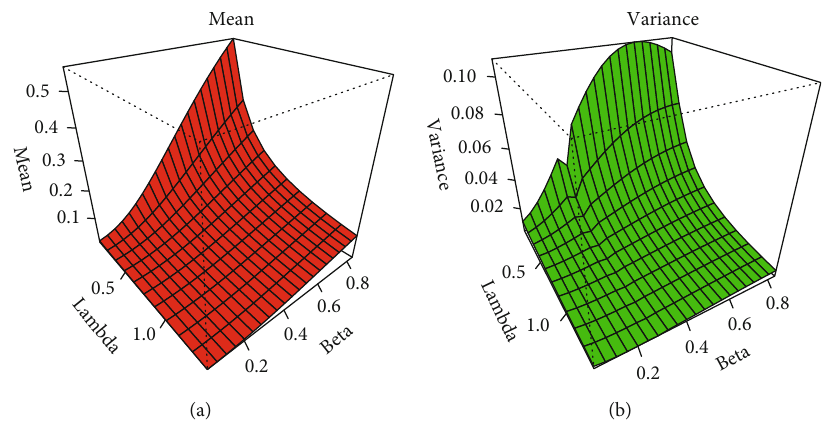
Figure 4: Graphical illustration of (a) mean and (b) variance of UPWD model.